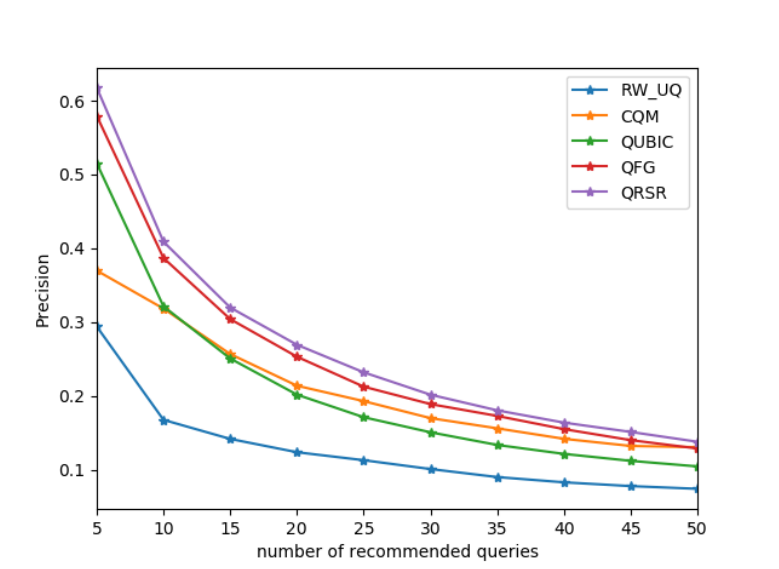
Figure 8. Compare precision with other algorithms.